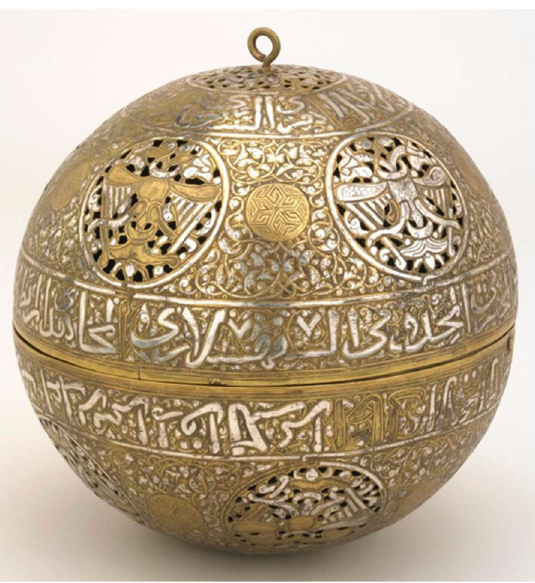
Figure 11. Brass incense burner. Made in Damascus. Diameter: 18.4 cm; height: 18.5 cm. British Museum.